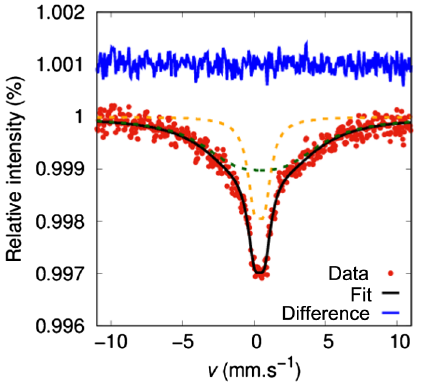
FIG. 10. Room-temperature Mössbauer spectrum. Orange and green dashed lines correspond to the fitted doublet and broad sextet subspectra,